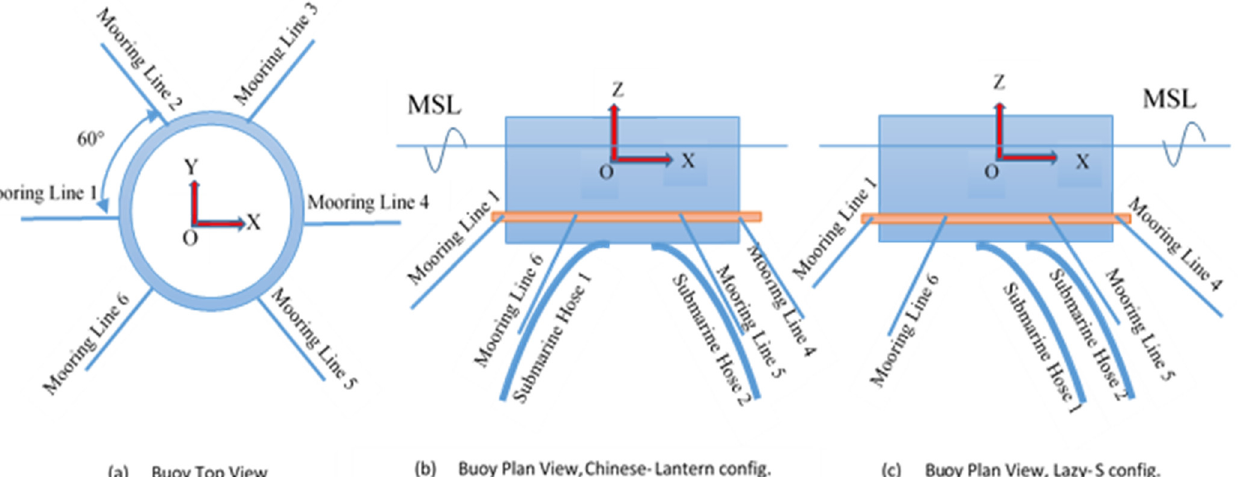
Figure 6. Submarine hose profile showing the radii for inner and outer surfaces in Orcaflex. Table 4. Parameters for the mooring lines.